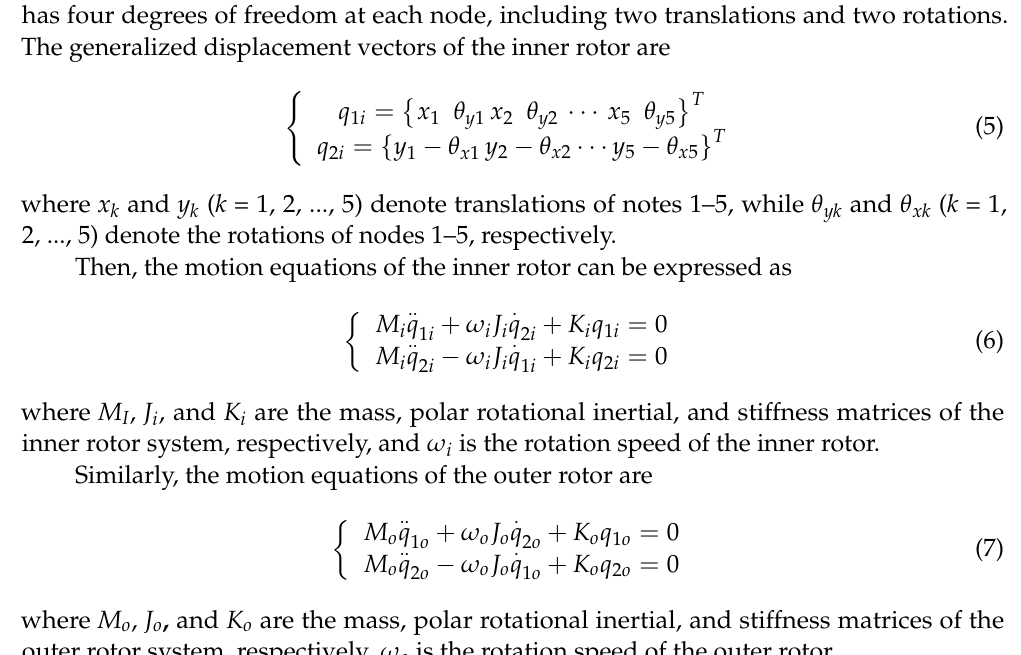
Figure 5. Bearing capacity curves. ( a ) e = 0; ( b ) e = 20%.